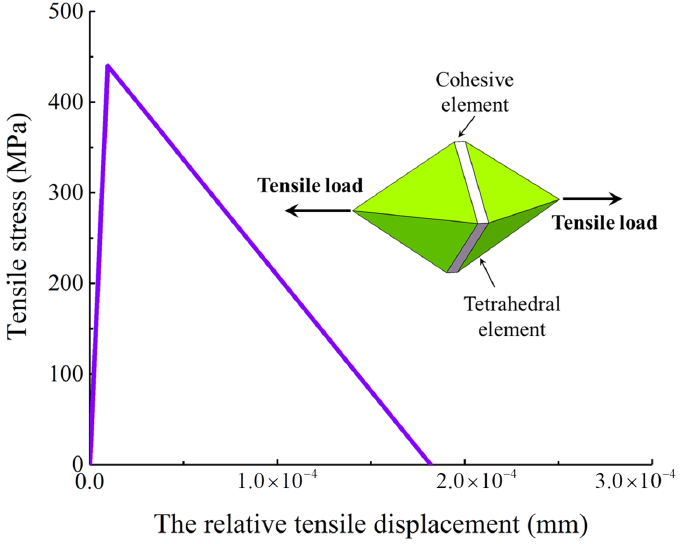
Figure 1. The mode I constitutive behavior of the cohesive element with K 1 = 4.6 × 10 7 N/mm 3 , = 0.04 N/mm. In the inset figure, a cohesive (crack) element is interspersed σ 0 = 440 MPa, and G c 1 throughout two tetrahedral